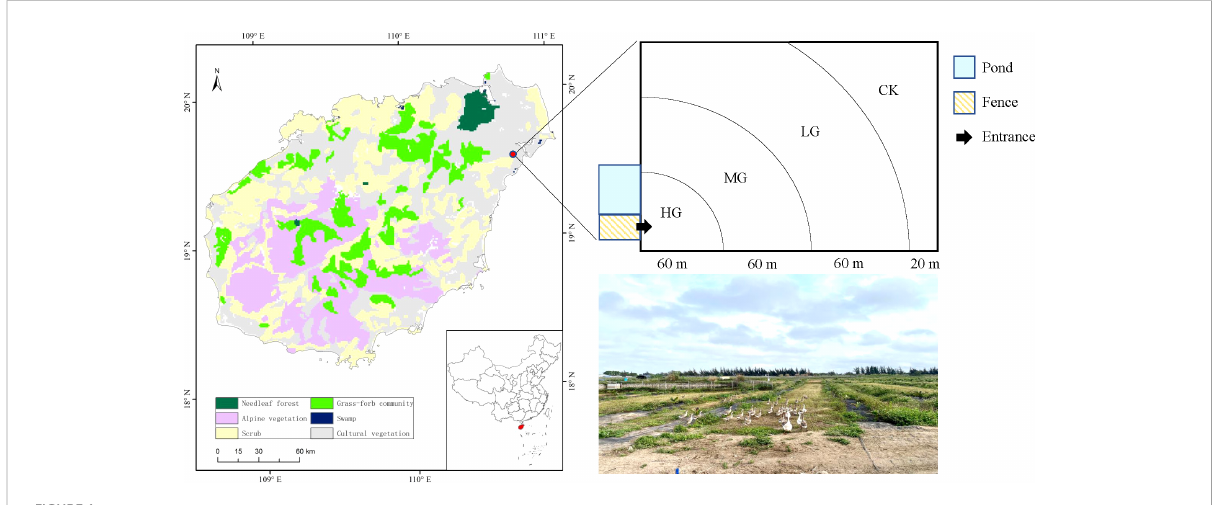
FIGURE 1 Study site and schematic representation of geese grazing